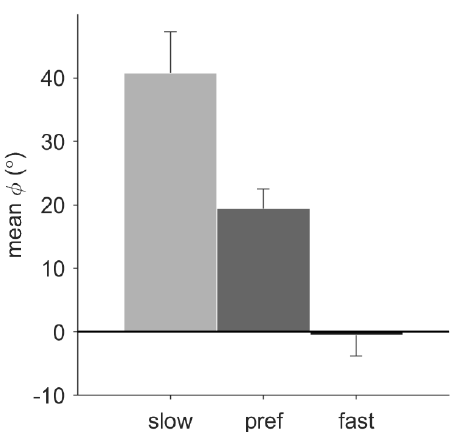
Figure 3. Mean relative phase ( φ ) during stationary auditory-motor coordination for walking with the different pacing frequencies ( N = 11). Error bars represent the standard error of the mean. Variability of the relative phase was significantly higher with stride-based (5.48